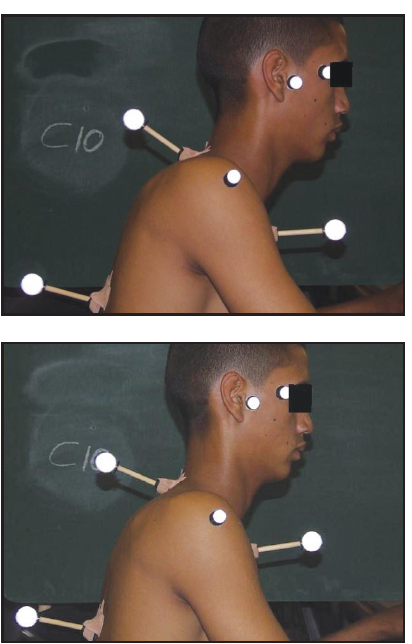
Figure 4: Most common pos - tural change over ten